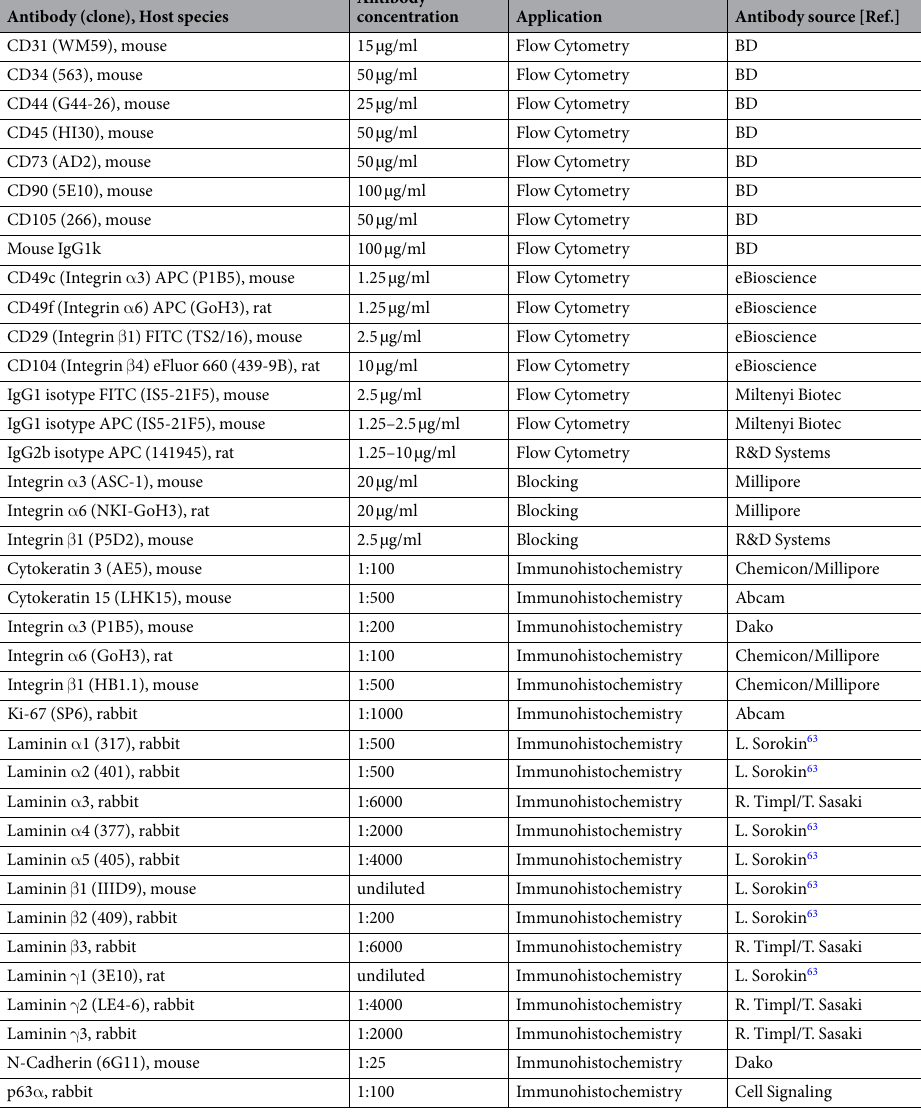
Table 1. List of antibodies